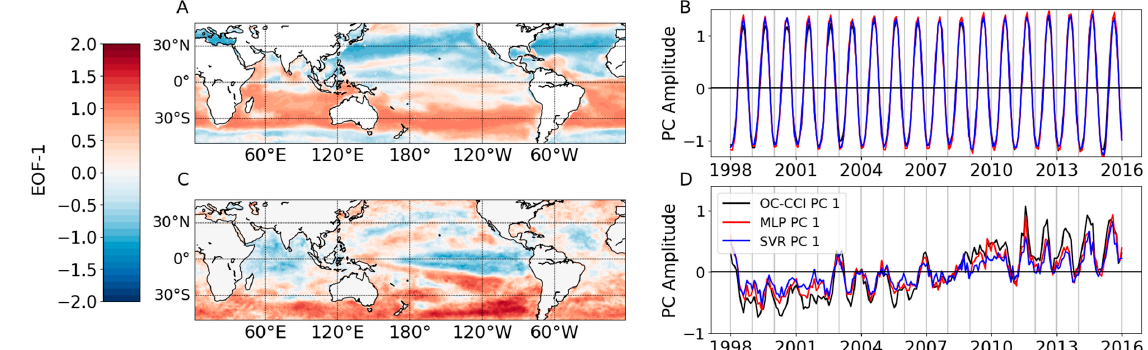
Figure 4. First mode of the Chl OC-CCI ( A ) seasonal and ( C ) interannual EOFs over 1998–2015, and their associated principal components ( B ) and ( D ), respectively. Chl MLP and Chl SVR PCs obtained from the Chl OC-CCI EOF projections are reported in ( B ) and ( D ).